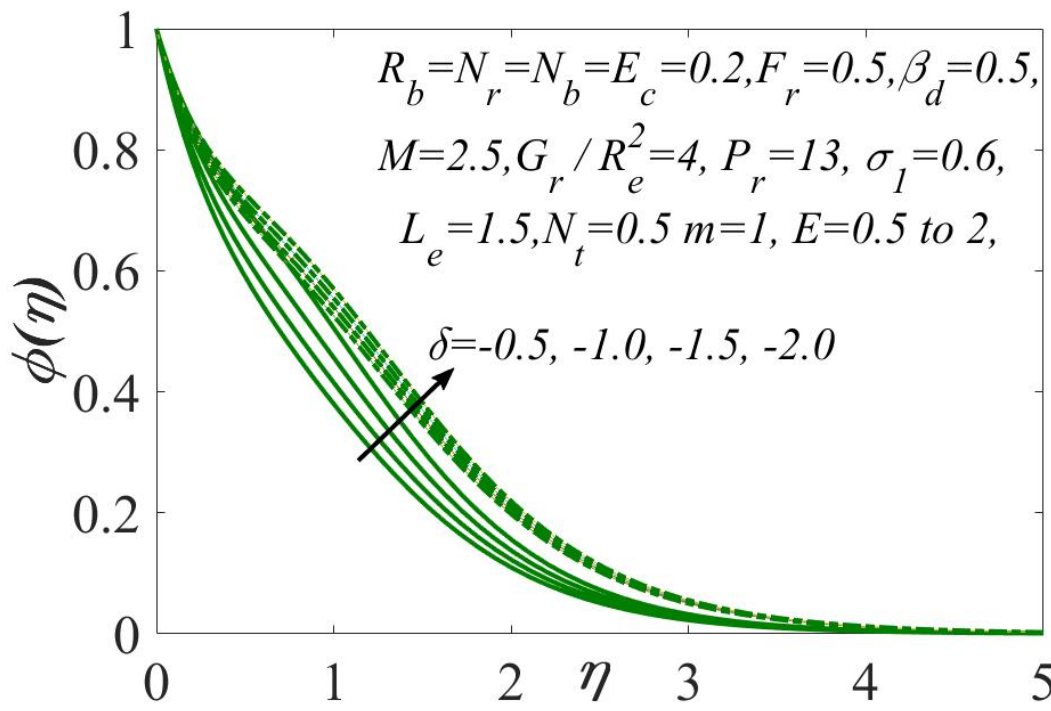
Figure 12. Variation in (cid:2026) (cid:2869) and (cid:1831) on concentration distribution. Solid line: (cid:1831) = 0.5 , Dotted line: (cid:1831) = 1.0.